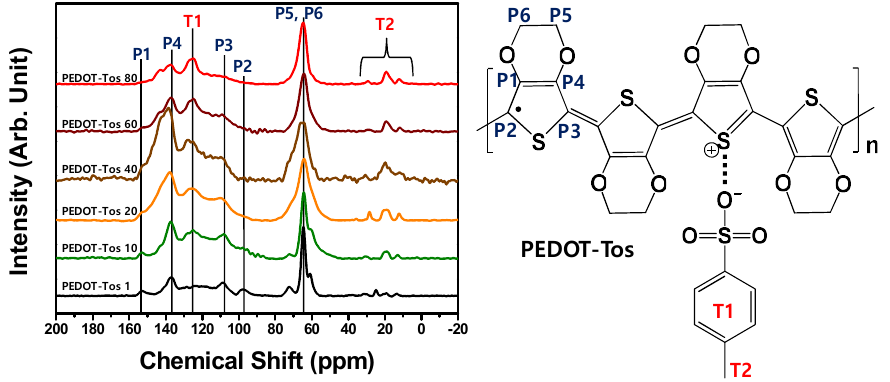
P3P4P5P6 P5, P6 T1 P1 P2 PEDOT-Tos T1 T2 Figure 1. 13 C solid-state nuclear magnetic resonance (NMR) spectra of the Poly(3,4-ethylenedioxythiophene)-tosylate (PEDOT-Tos) samples are presented. The inset shows the chemical structure of PEDOT-Tos.